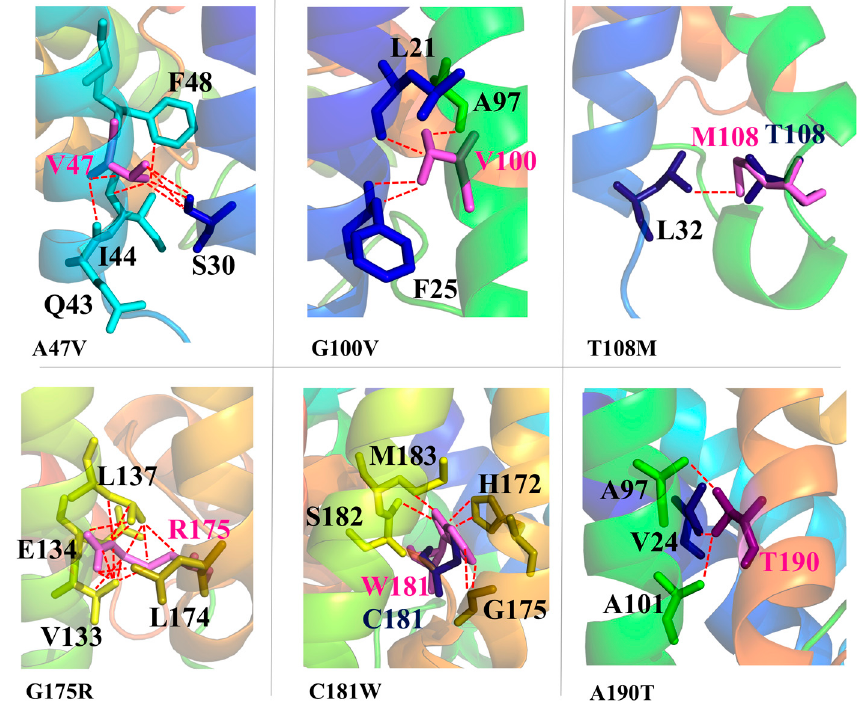
Figure 6. Mutations causing intra-monomer clashes. Cartoon representation of AQP2 mutants with mutated residues shown as violet sticks and clashing residues colored as the helix to which they belong. Dotted red lines indicate clashes. The wild type residues are shown in blue only when different from Gly or Ala, i.e., for T108 and C181, to pinpoint the lack of clashes in these cases.